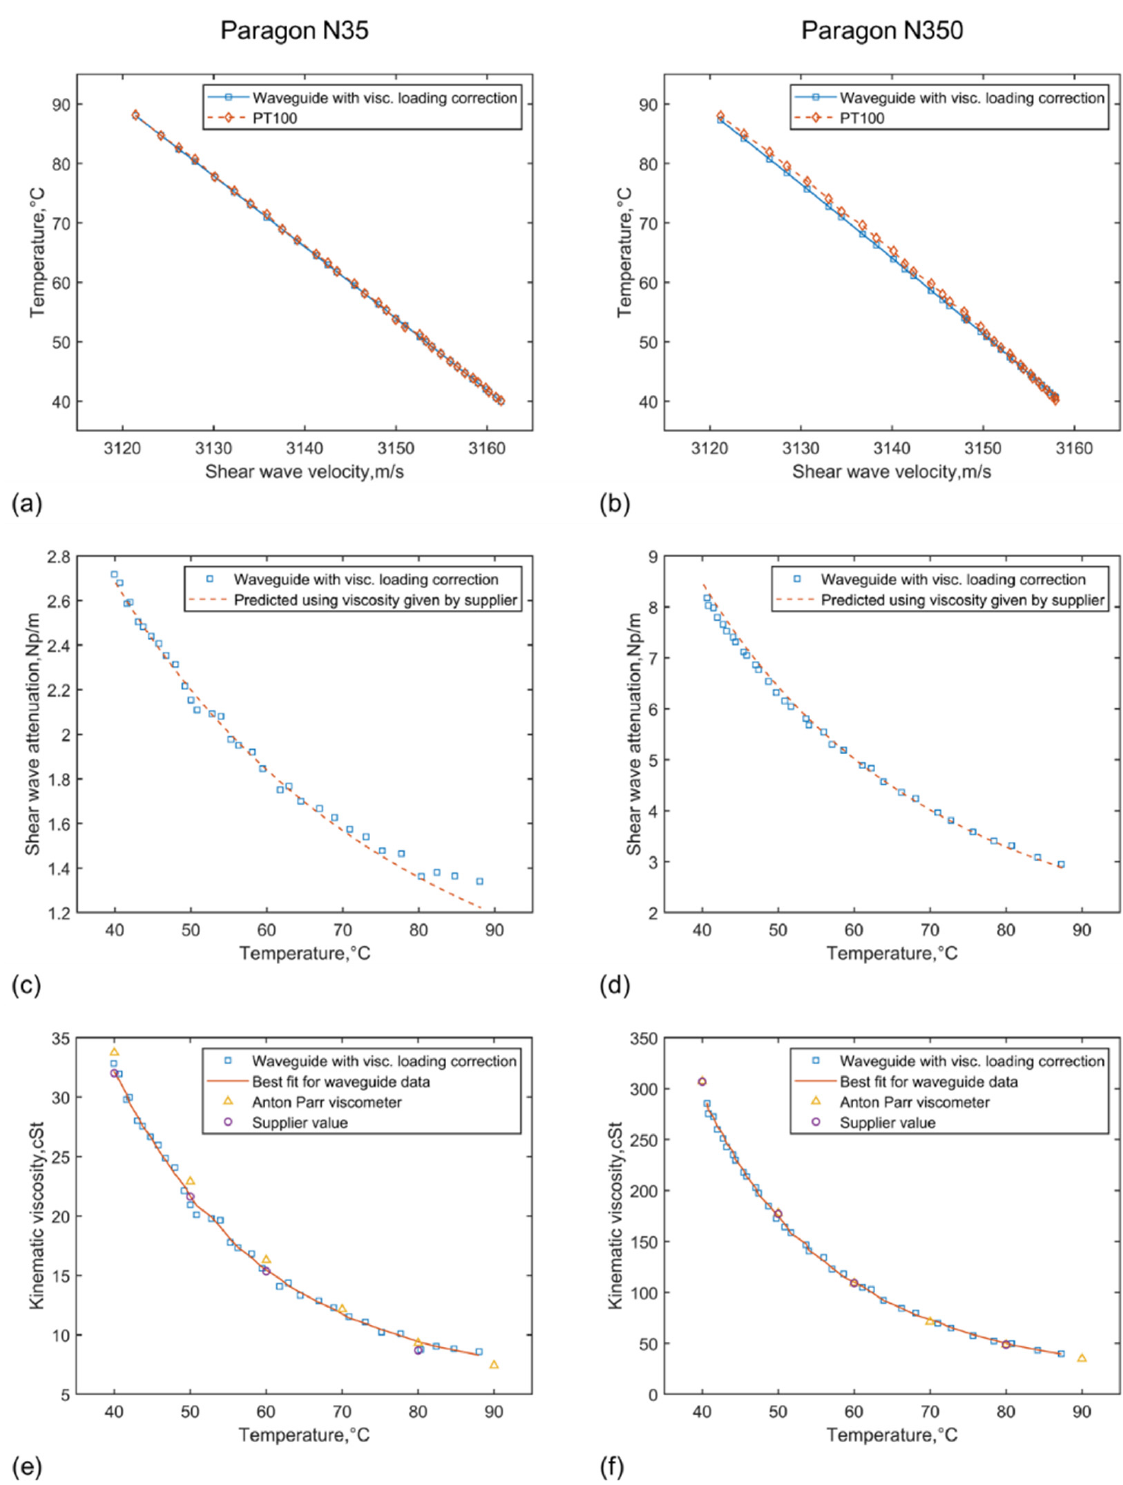
Figure 8. Temperature, attenuation and viscosity predictions corrected using the literation algorithm for Paragon N35 ( a , c , e ) and Paragon N350 ( b , d , f ), where the temperature is compared with measurements with PT100, the attenuation is compared with that predicted using the kinematic viscosity provided by the viscosity standard supplier, and the viscosity predicted is compared with measurements using the Anton Parr viscometer and the values provided by the viscosity standard supplier (Results for predictions with correcting for viscous fluid loading effect on the wave velocity).